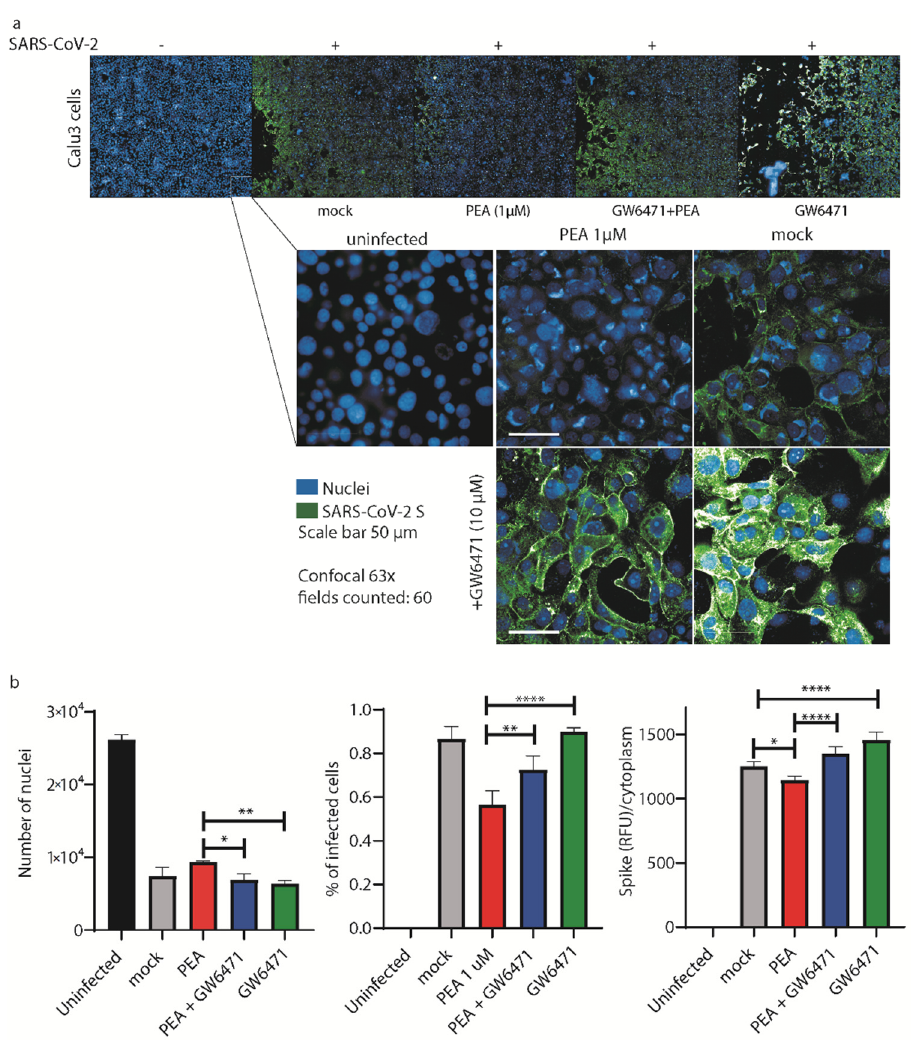
Figure 7. PEA decreases SARS-CoV-2 entry in Calu-3 cells. ( a ) (upper panel) High-content automatic confocal microscopy screening of SARS-CoV-2-infected cells (green) treated or not with PEA and PPAR- α antagonist GW6471 (10 μ M). (lower panel) Representative images of Calu-3 cells infected or not with SARS-CoV-2 mixed or not with PEA. Cells were also treated or not with GW6471. Sixty fields were acquired per well. ( b ) Statistical analyses of the number of nuclei detected in the screenings, percentages of infected cells, and the amount of SARS-CoV-2 S protein/cell. Data were analyzed using a 63× water objective. Data are expressed as means ± SD and were analyzed by a one-way ANOVA (n = 3, * p < 0.5, ** p < 0.01, **** p < 0.0001).